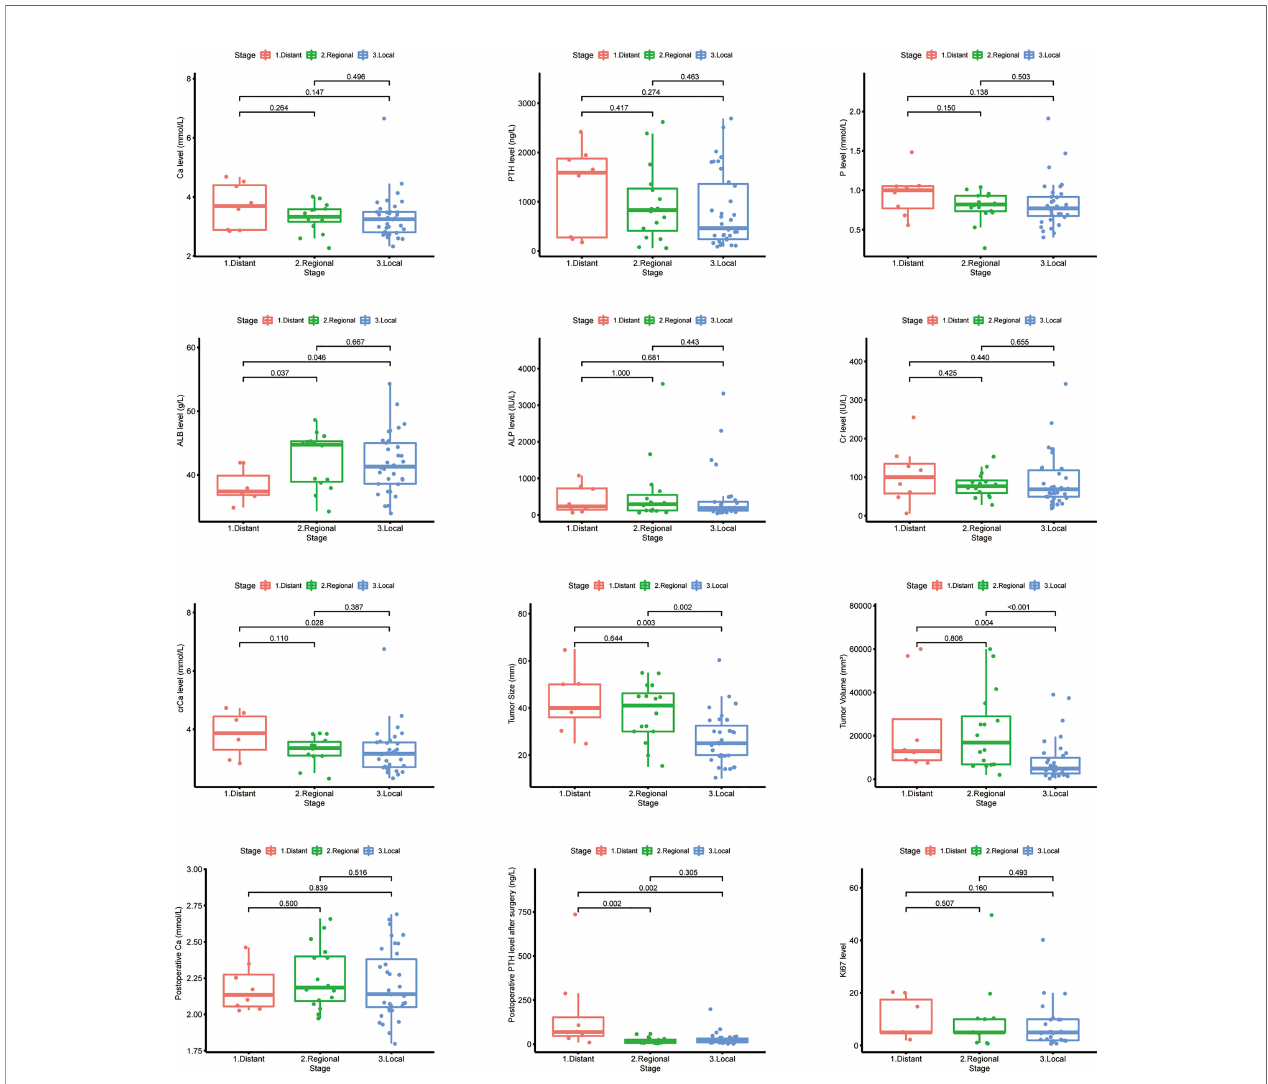
FIGURE 10 | Laboratory and pathologic indicator levels among different stages in Chinese single-center parathyroid carcinoma